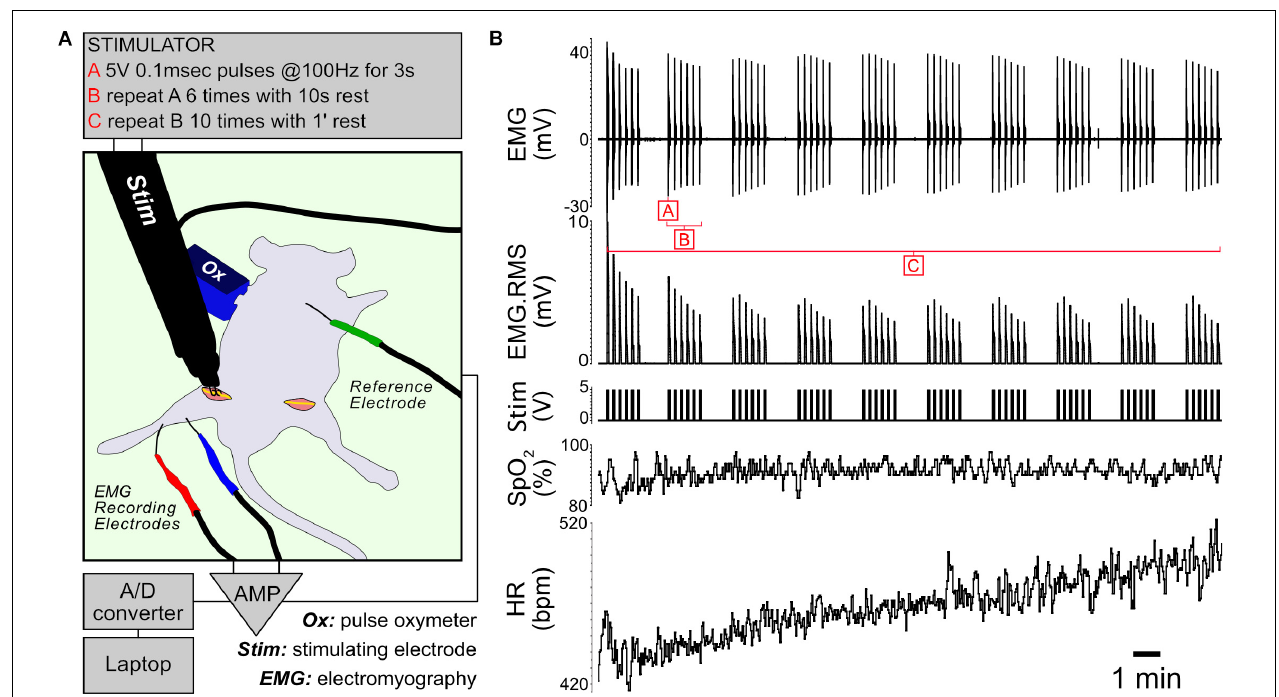
FIGURE 1 | In vivo stimulation protocol. (A) Diagram of the experimental setup. The unstimulated limb underwent a sham procedure before dissecting the muscles of interest. (B) Representative traces showing EMG, RMS (root mean square) of the EMG trace, stimulation, capillary oxygen saturation and heart rate measured during the